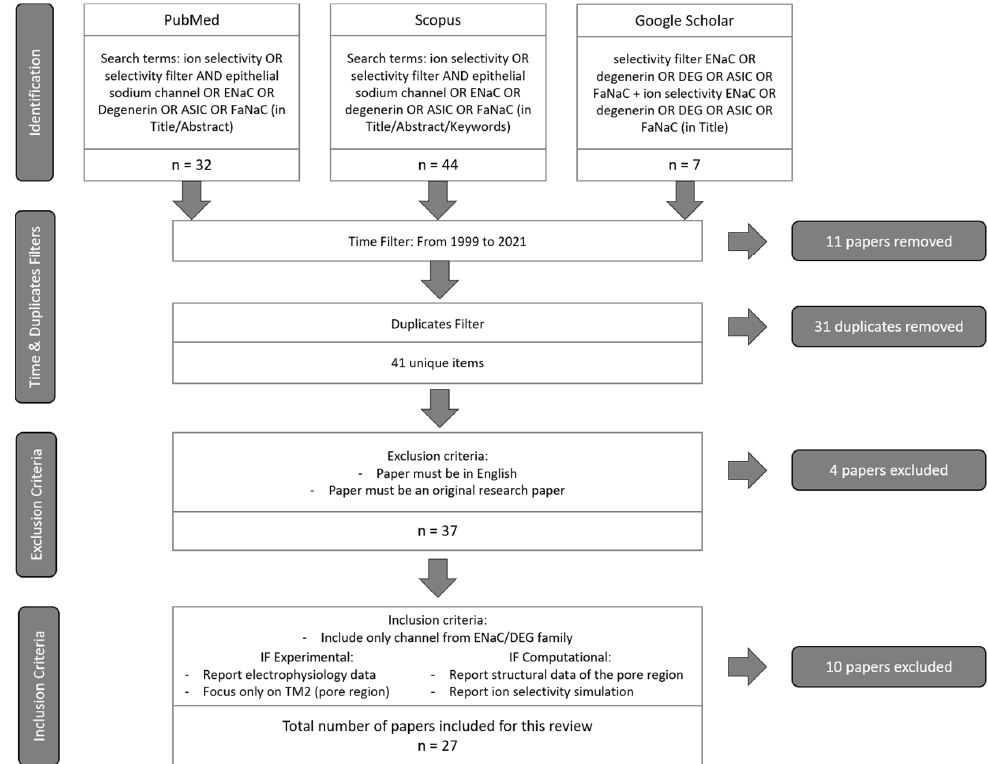
Figure 1. Flowchart of the search strategy for this review . Search was carried out in July 2021. The